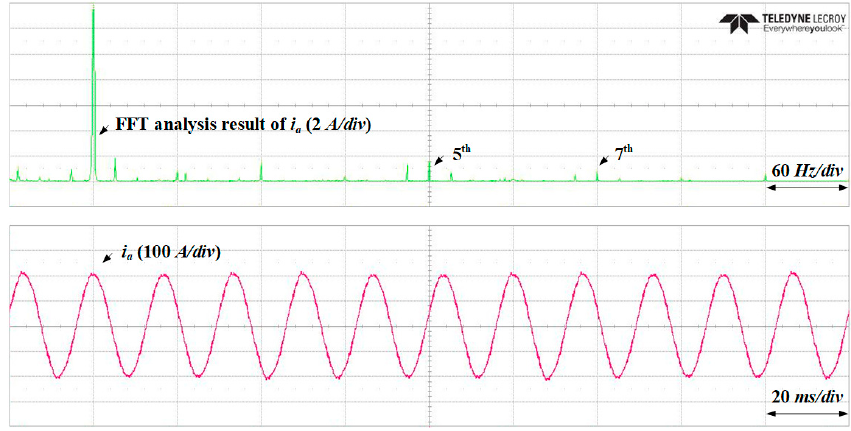
Figure 24. Experimental results when a harmonic compensation method is applied: SHE method.